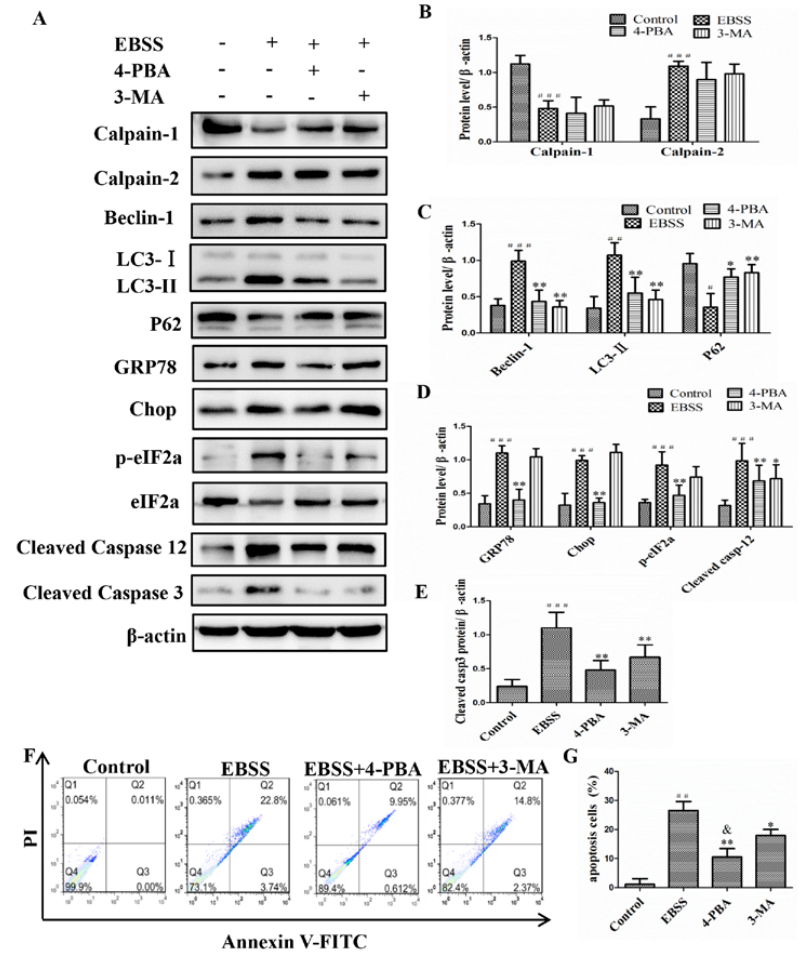
Figure 4. Inhibition of ER stress and autophagy attenuated EBSS-induced apoptosis in ARPE-19 cells. ( A – E ) The expression levels of calpain-1, calpain-2, ER stress-related